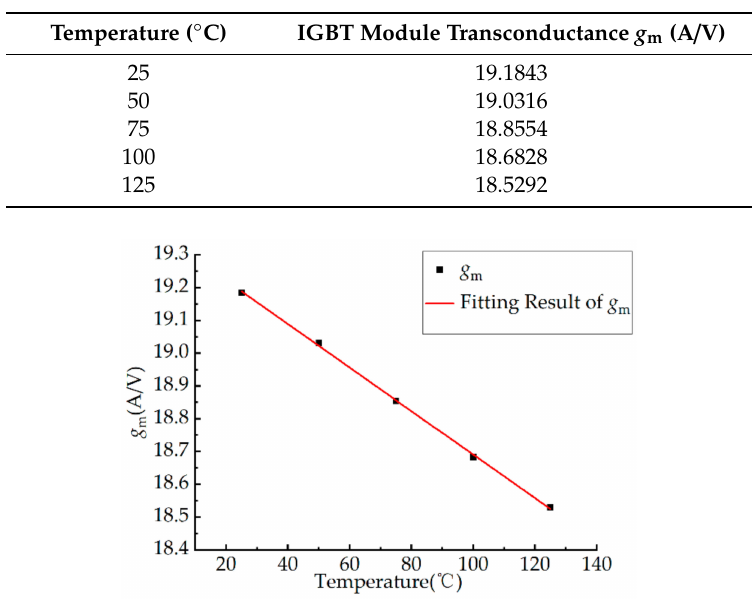
Table 3. Transconductance of the IGBT module in a healthy state at di ff erent temperatures.